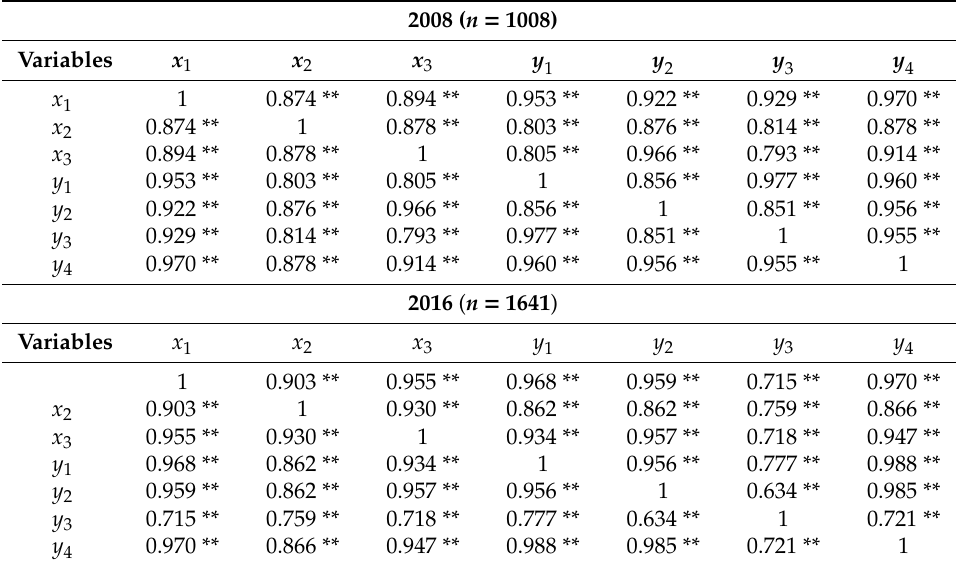
Table A3. Correlation matrix between input and output variables, 2008 and 2016. 2008 ( n =